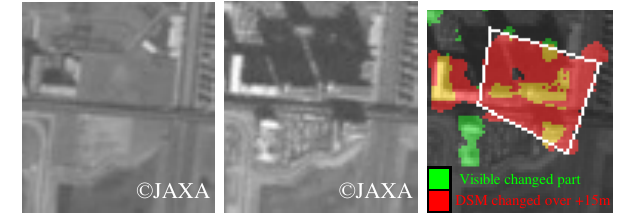
Figure 11: Example of conbined DSM Left: 1 st orthoimage Cnter: 2 nd orthoimage, Right: change detected image with a polygon overlayed with 2 nd